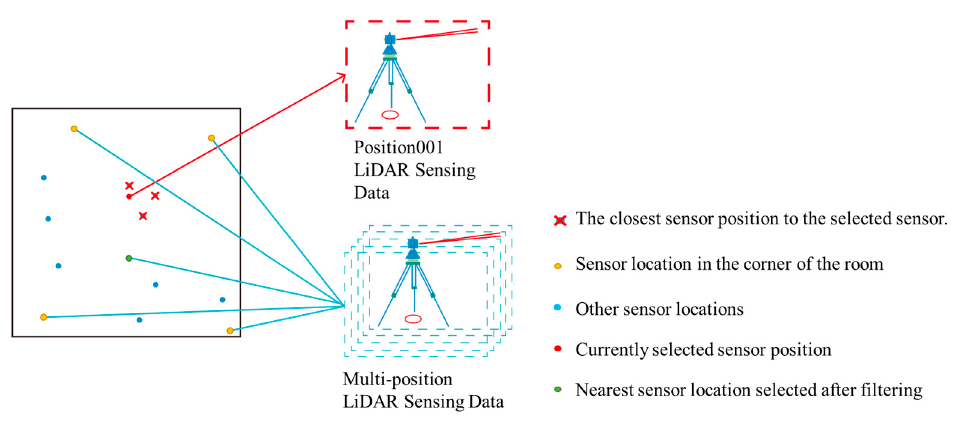
Figure 11. Overview based on the scattered peripheral sensor selection method.